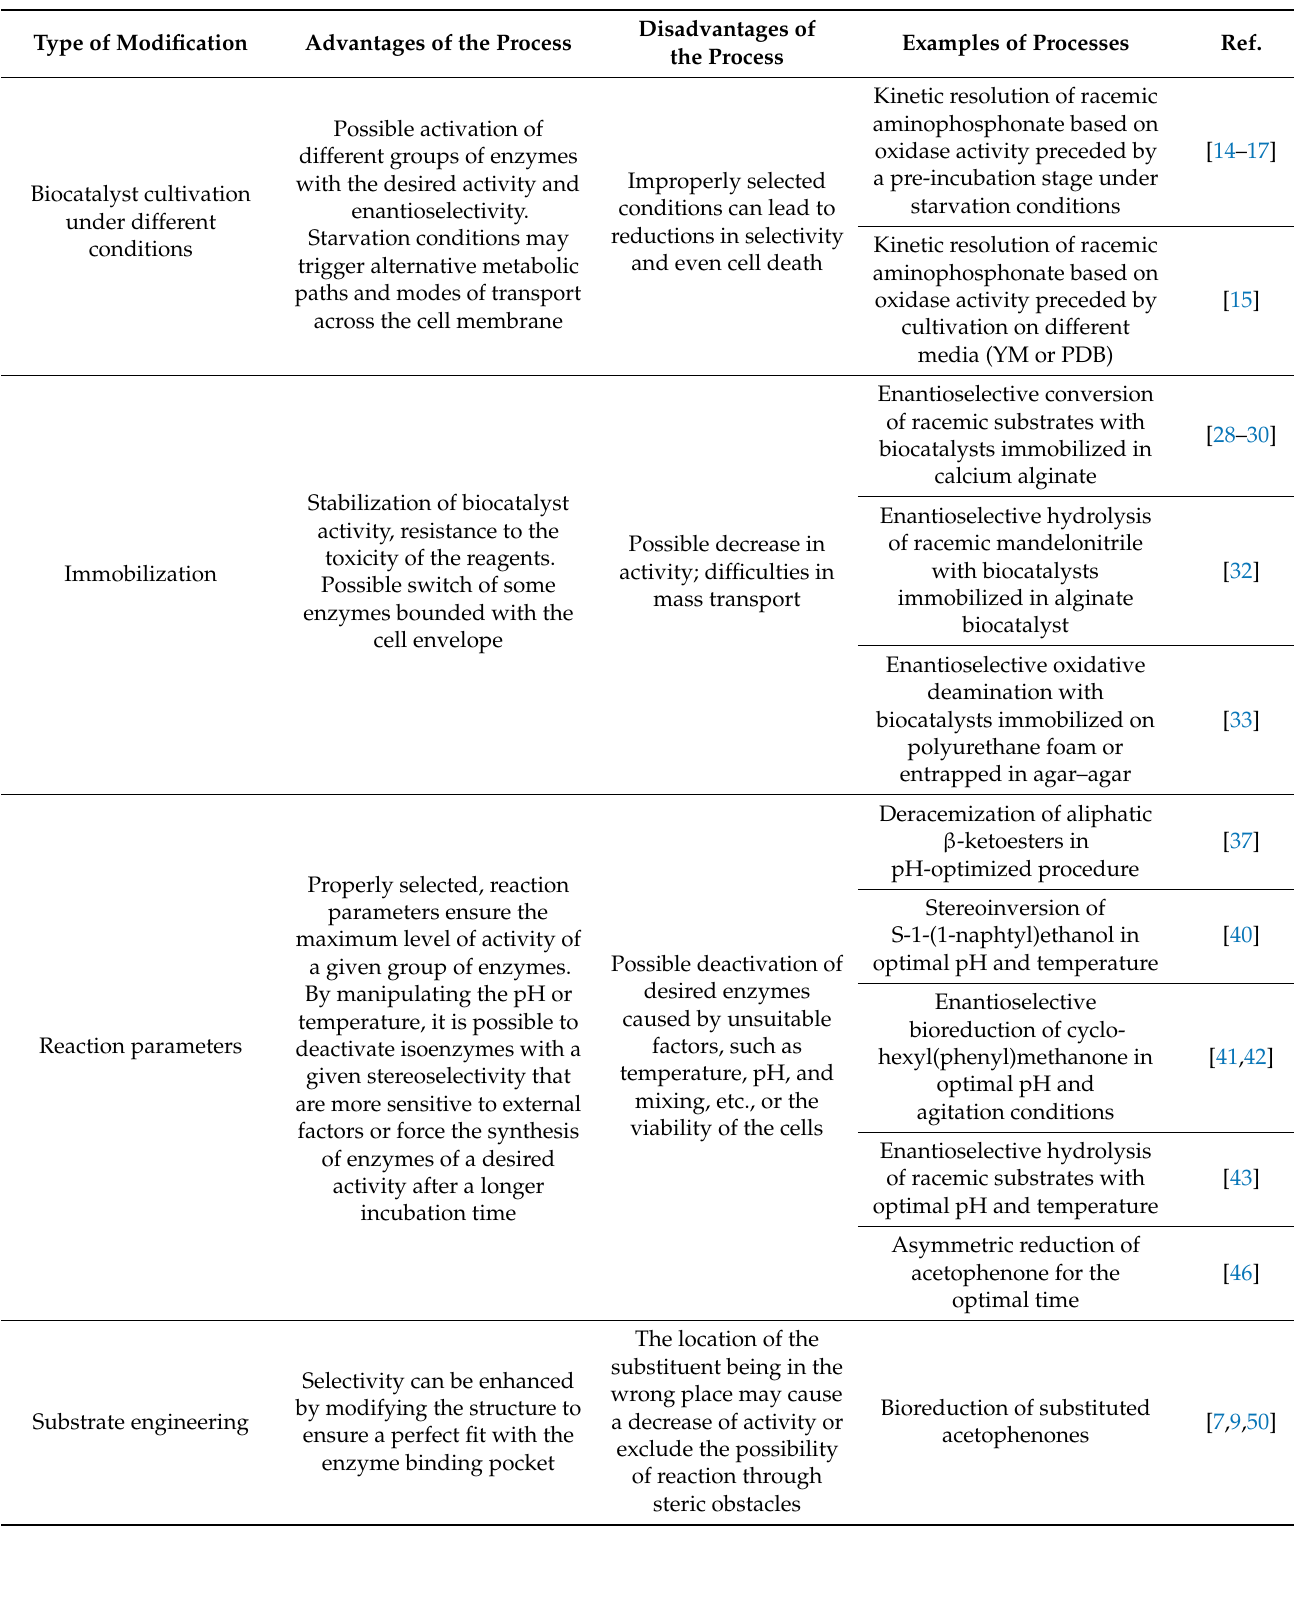
Table 2. Examples of processes influenced by different physicochemical